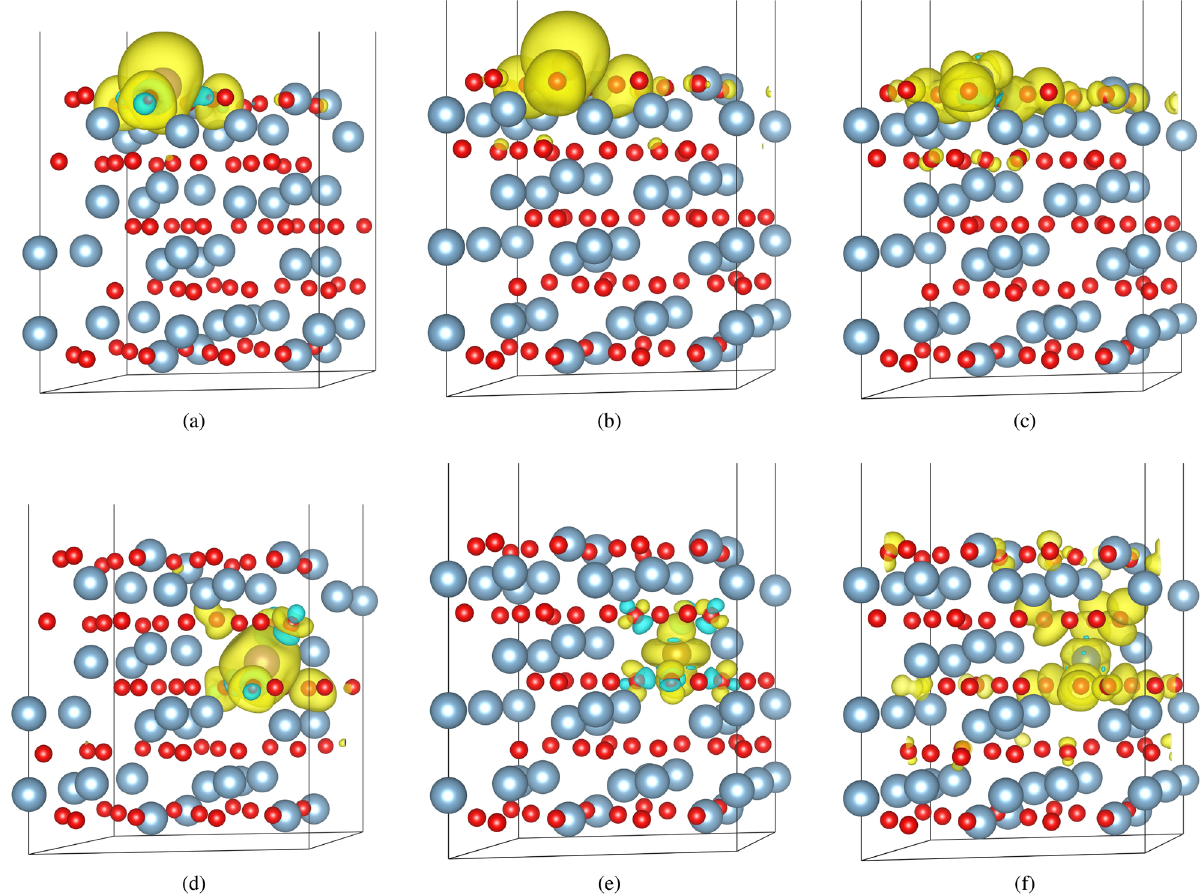
Figure 5. The spin density distribution 0.0015 µ B Å − 3 isosurfaces for ( a ) Mn, ( b ) Fe, and ( c ) Cu doped into the surface of α -alumina along with the spin density distribution for ( d ) Mn, ( e ) Fe, and ( f ) Cu doped into the bulk- like region of the slab. The larger (Blue) atoms are Al, the smaller (red) atoms are O, and the remaining atom is the dopant. Yellow represents the up (majority) spin isosurfaces, aquamarine represents down (minority) spin isosurfaces. Some Al and O atoms were removed from the super cell to increase